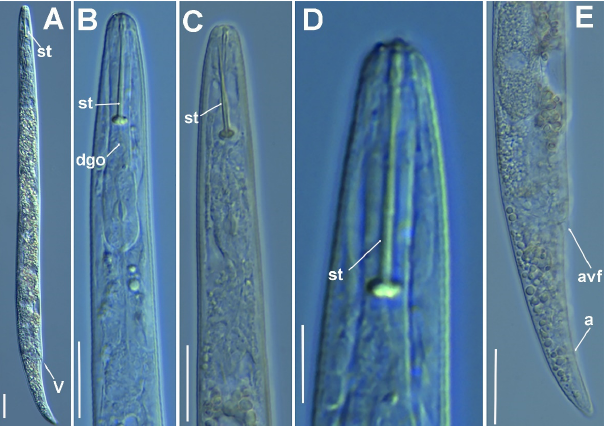
Figure 7. Micro-photomicrographs of Paratylenchus canchicus Mohilal and Dhanachand, 2004 female. ( A ) Whole female with vulva arrowed; ( B,C ) Pharyngeal region; ( D ) Lip region; ( E ) Female posterior region with vulva and anus (arrowed) and detail of vulva showing advulval flap membrane (arrowed). Scale bars ( A – C , E = 20 µ m; D = 10 µ m). (Abbreviations: a = anus; avf = advulval flap; dgo = dorsal gland orifice; st = stylet; V = vulva).